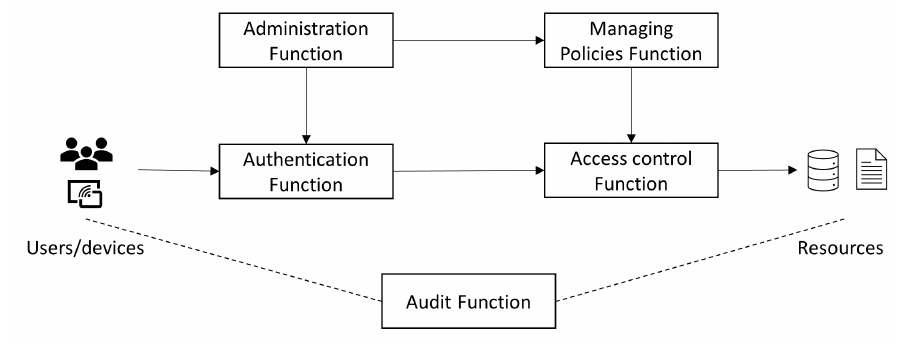
Figure 1. Access Control Process in the